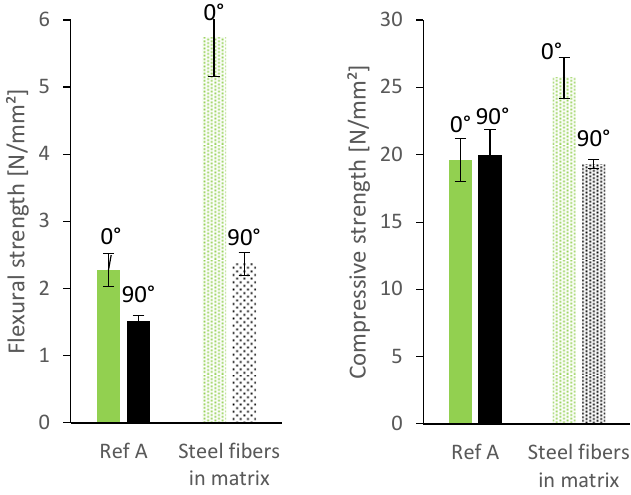
Figure 7. Flexural and compressive strength of specimen without and with micro steelfibers (cut out 0°/90° to printing direction).